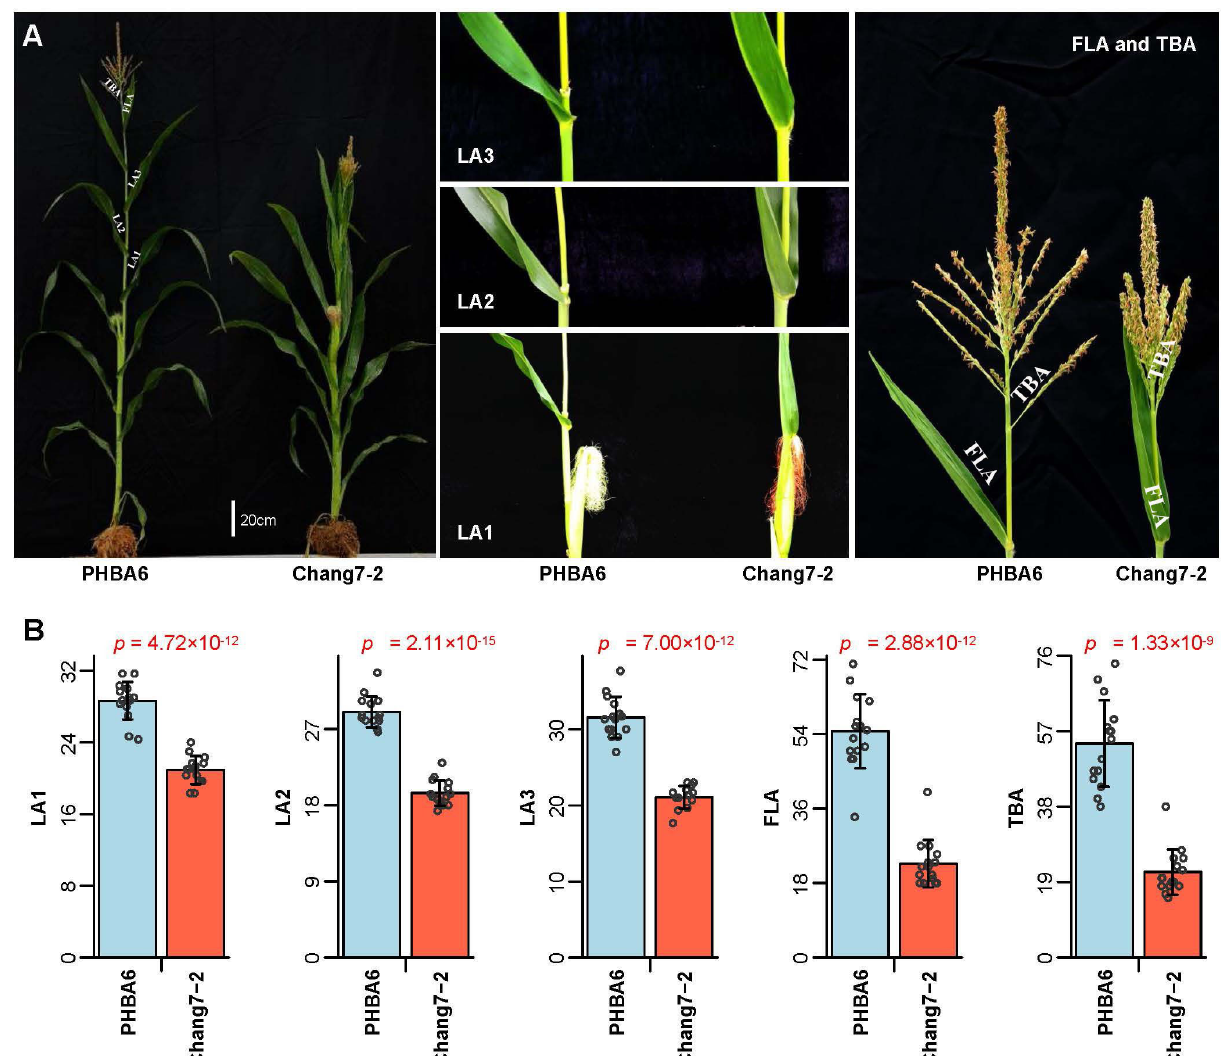
Figure 1. Phenotypic differences between the parental inbred lines PHBA6 and Chang7-2. ( A ) Com- parison of plant morphology and angles of the first leaves (LA1), second leaves (LA2), third leaves (LA3), and flag leaves (FLA) above the upmost ear and the angles of the first tassel branch (TBA) between PHBA6 and Chang7-2. ( B ) Bar plot of LA1, LA2, LA3, and FLA above the upmost ear and the TBA of PHBA6 (n = 15) and Chang7-2 (n = 15). p -values of two tailed t -test are shown above each plot.